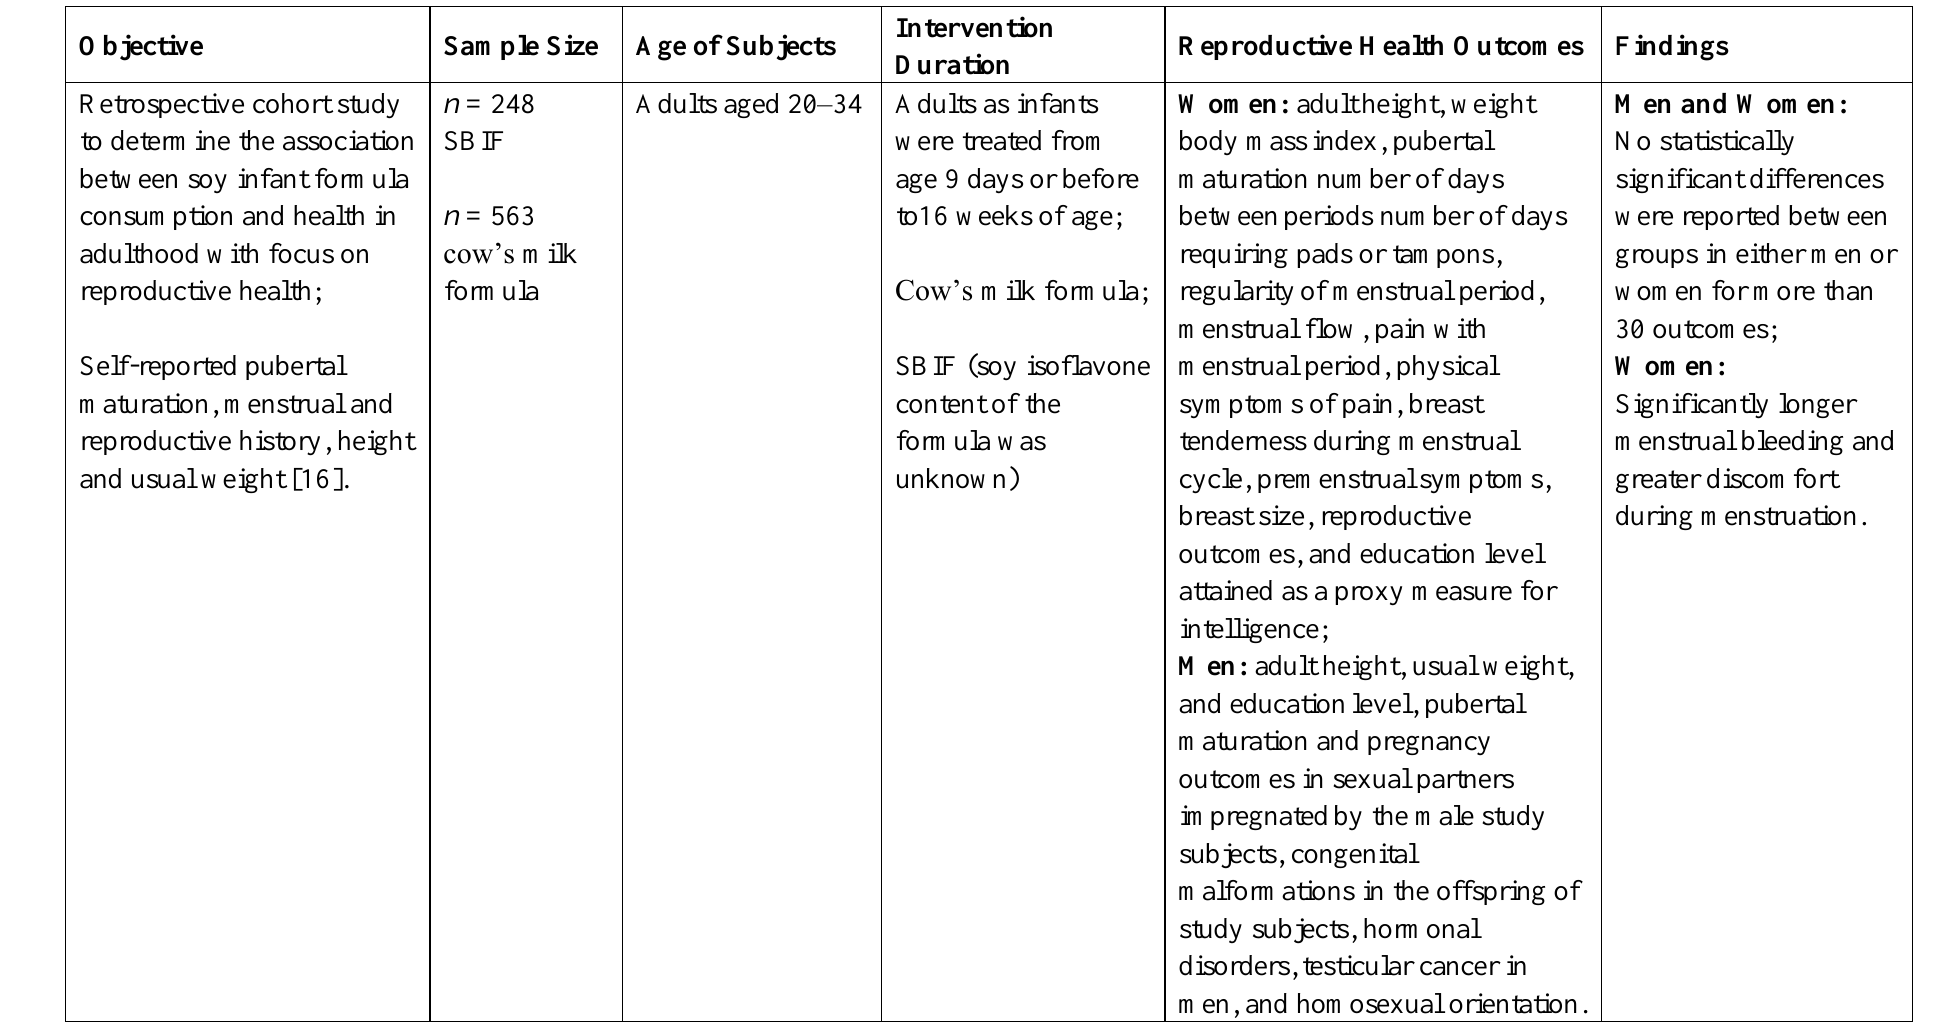
Table 4. Studies examining the effect of soy isoflavone exposure in early life on human